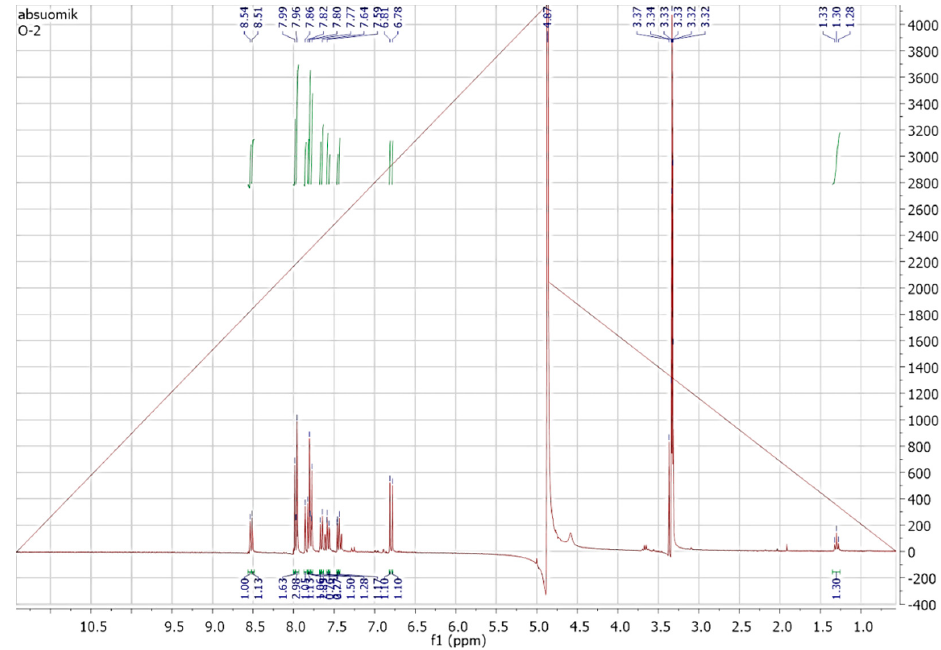
Figure 9. 1 H NMR of the original dye, orange II.